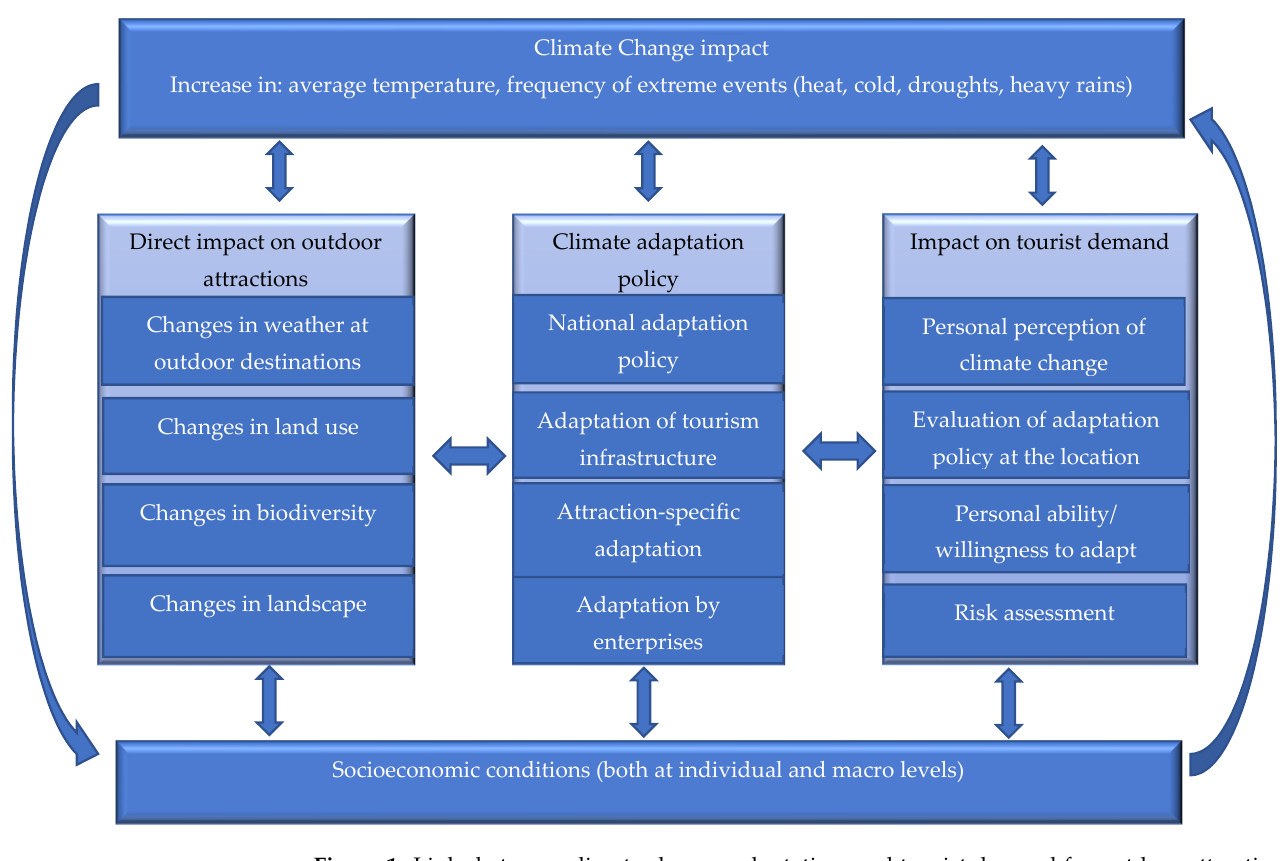
Figure 1. Links between climate change, adaptation, and tourist demand for outdoor attractions. Authors’ adaptation based on Pröbstl-Haider et al.